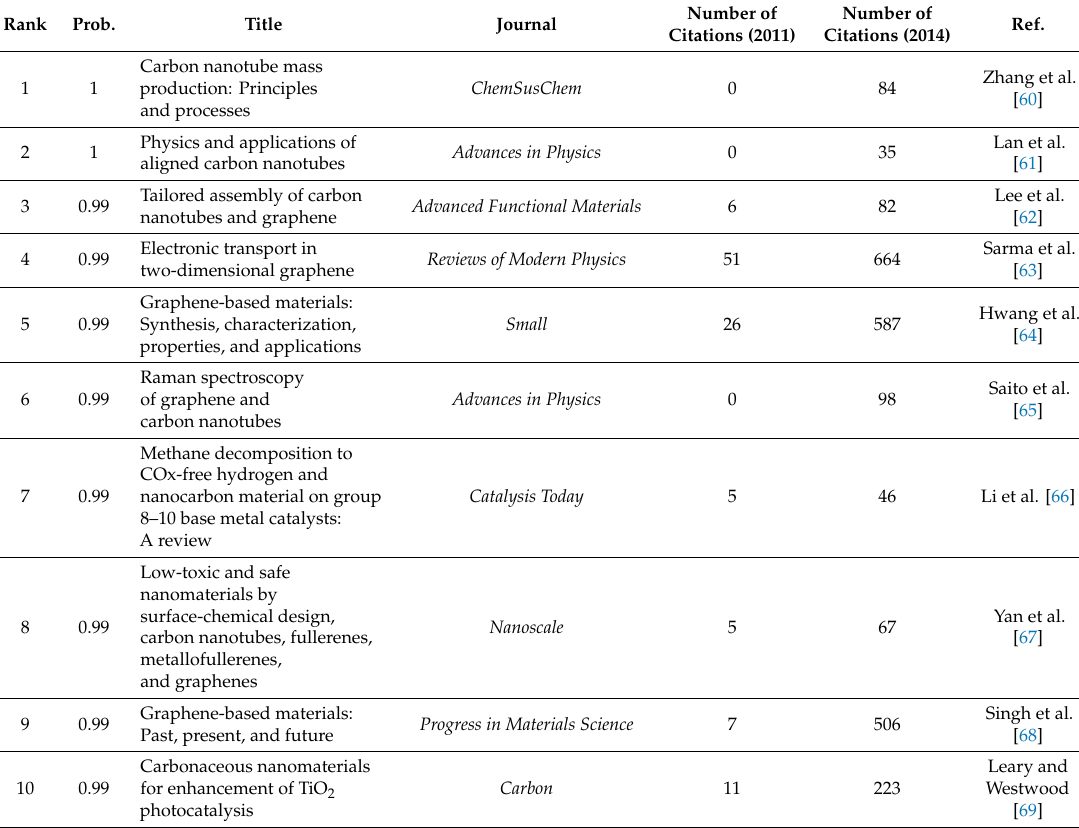
Table 5. Top ten papers published in 2011 that were predicted to be most likely to be emerging.